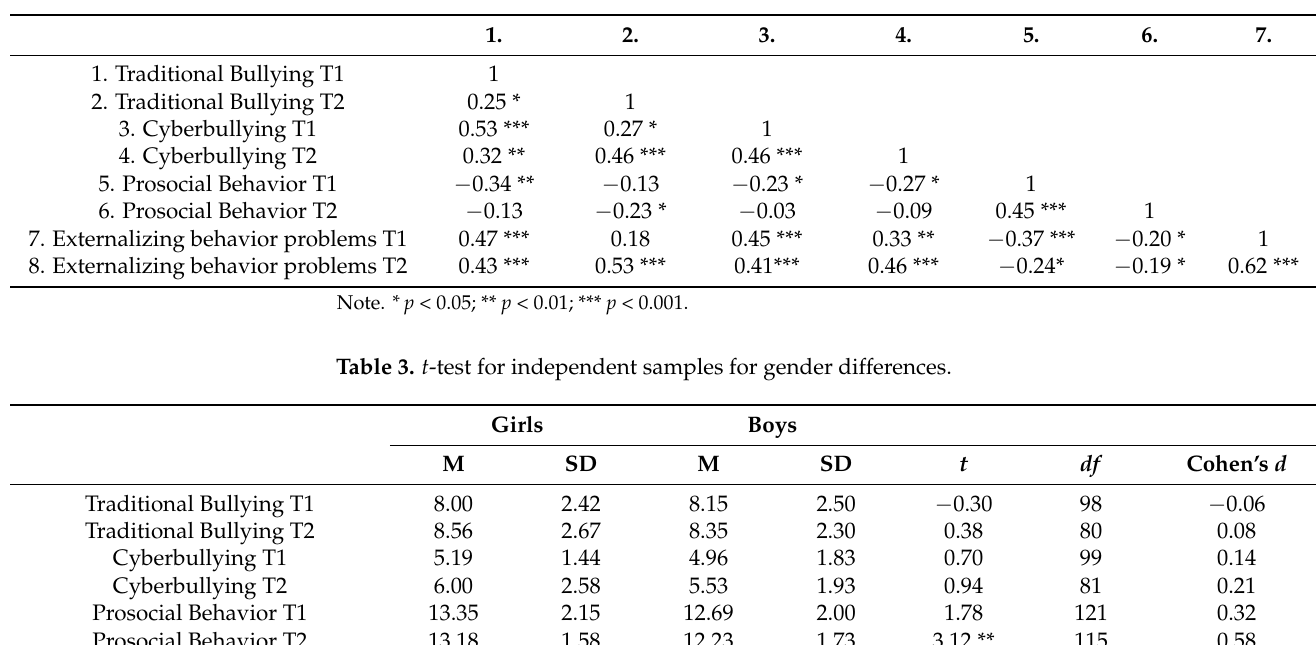
Table 2. Intercorrelations between the study variables.